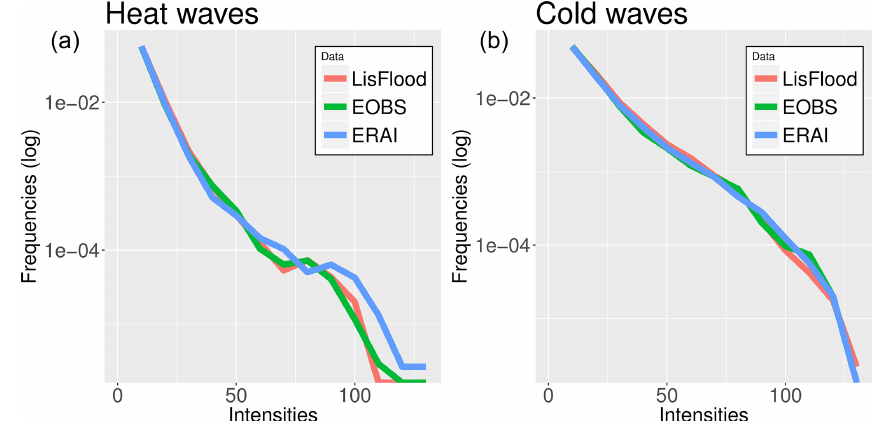
Figure 8. Histograms of heat (a) and cold (b) wave intensities defined as temperature anomalies (I2) for the three datasets. Note that the frequency axes are on a log